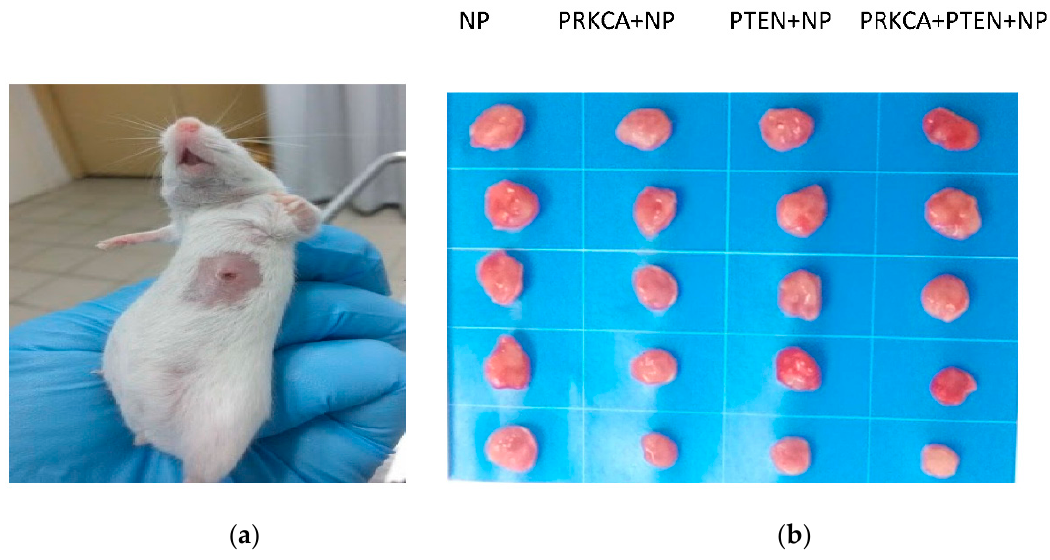
Figure 5. ( a ) Following subcutaneous injection, tumour growth appeared on mouse mammary pad and reached an approximate volume of ~25 mm 3 within day 8. ( b ) Tumor images captured following sacrifice of mice. At the end of the study, at day 22, mice were humanely sacrificed and tumours were excised.